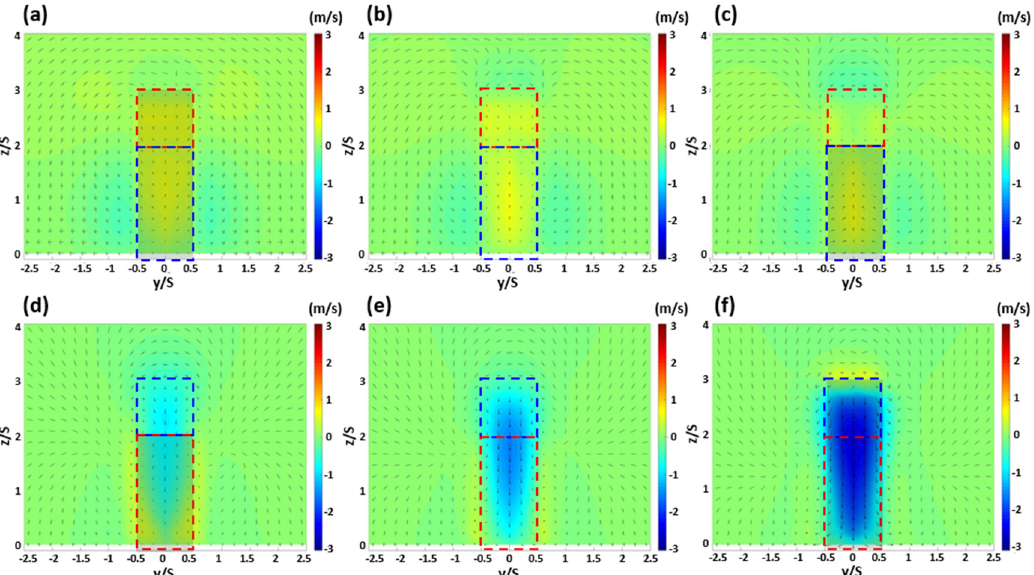
Figure 10. Wind field and vertical wind component of the first canyon (upper panel) and the second canyon (lower panel); x/S = − 1.4 ( a ), − 1.0 ( b ), − 0.6 ( c ), 0.6 ( d ), 1.0 ( e ), 1.4 ( f ) with numerical simulations in the case of step-down to step-up canyons; deep canyons. The windward buildings (red dotted box); leeward buildings (blue dotted box) of each canyon.